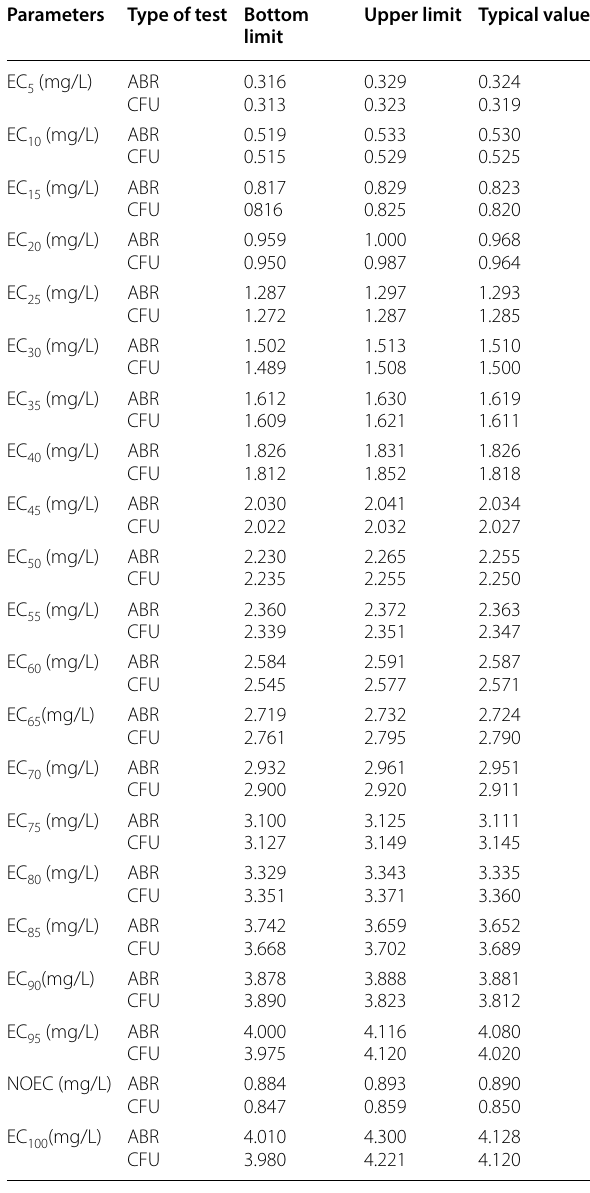
Table 7 The result of diazinon effect concentration in ABR and CFU tests by using E.